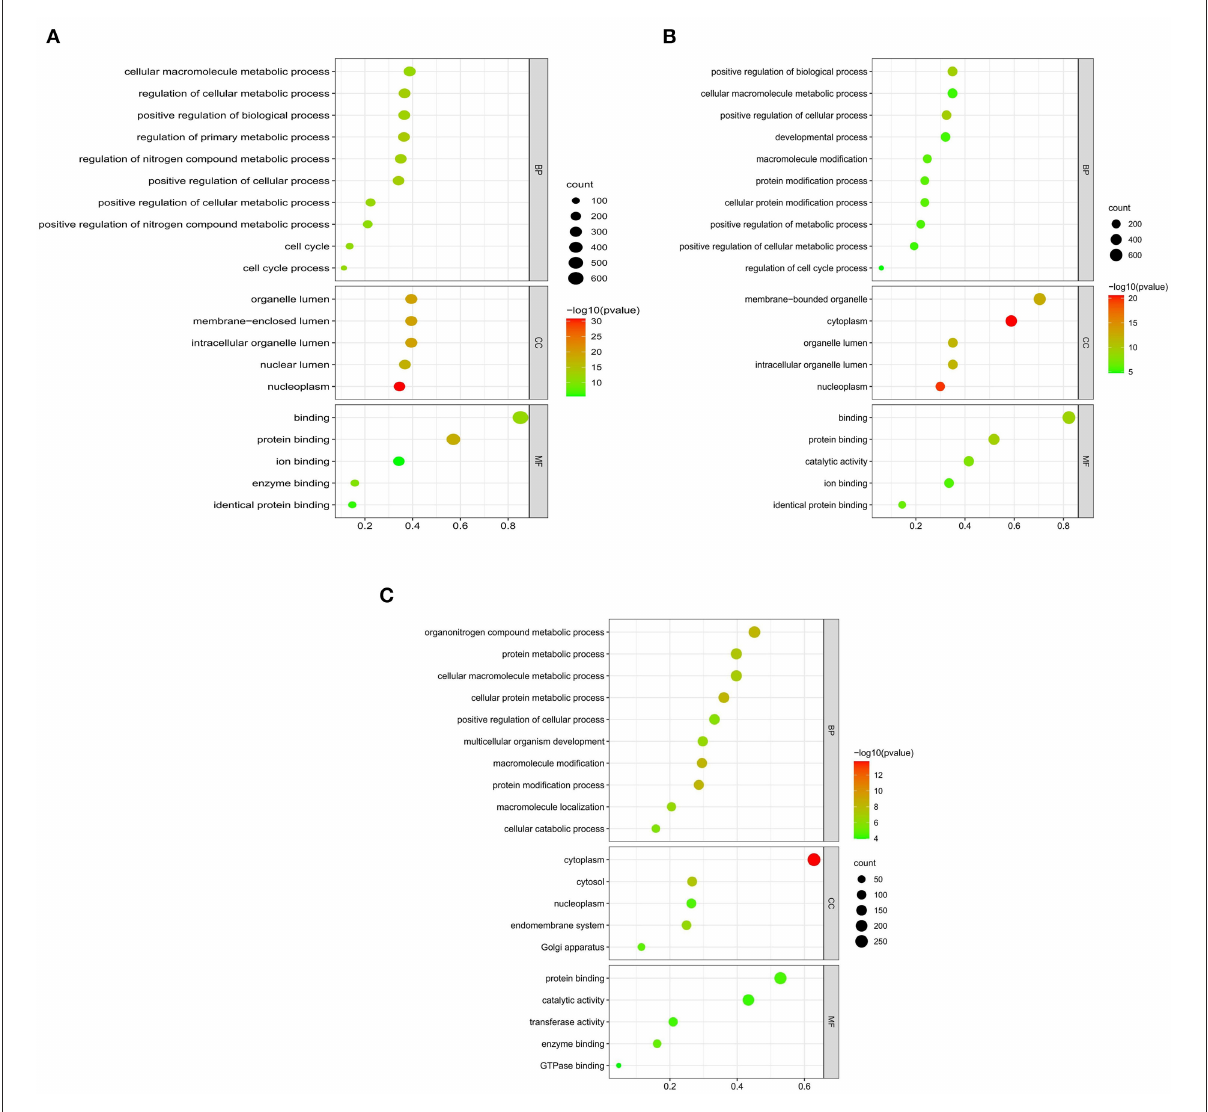
FIGURE4 GO enrichment analysis of DElncRNAs and DEmRNAs. (A) QD-QP. (B) QE-QP. (C) QM-QP.